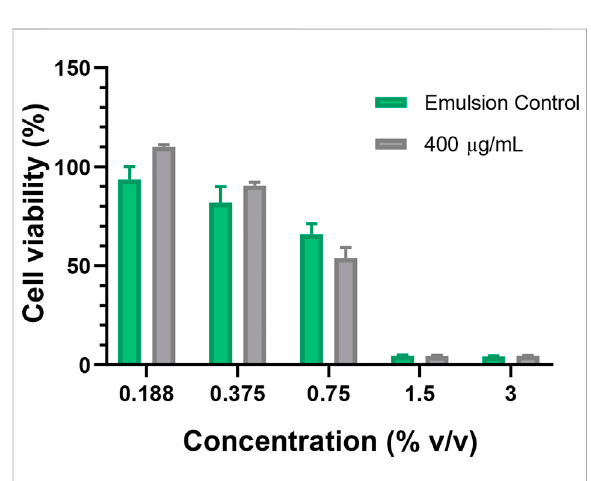
FIGURE 9 Cytotoxicity assay. The tested emulsion was prepared with the MNPs-PEG8-BUF-II-Ag nanobioconjugates (400 μ g/ml) at 60% wt. and HLB of 14. The emulsion prepared in the absence the nanobioconjugates was employed as